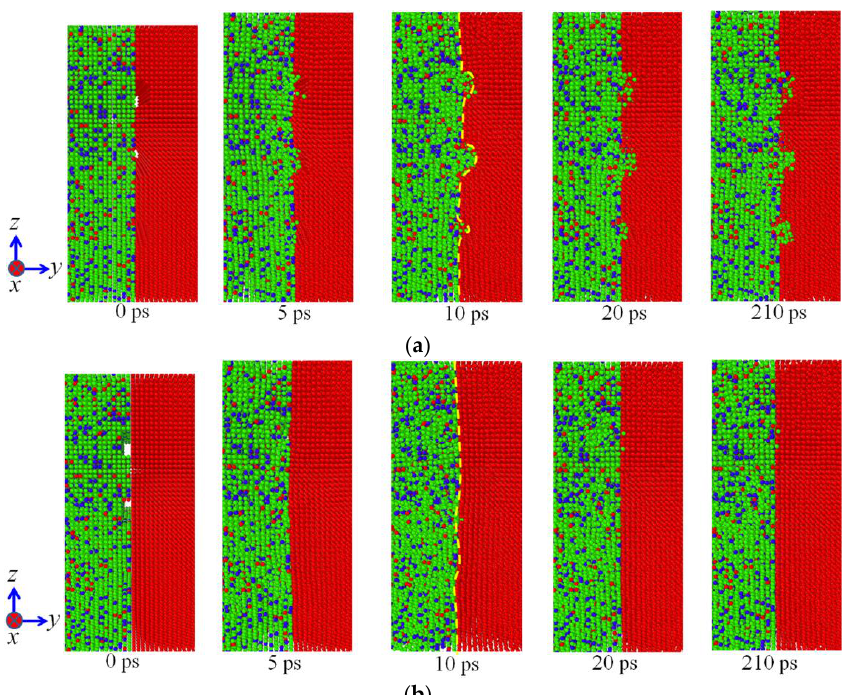
Figure 3. Evolution of diffusion configurations subjected to the vertical pressure of 50 MPa at 1200 K: ( a ) Model Ι; ( b ) Model ΙΙ.